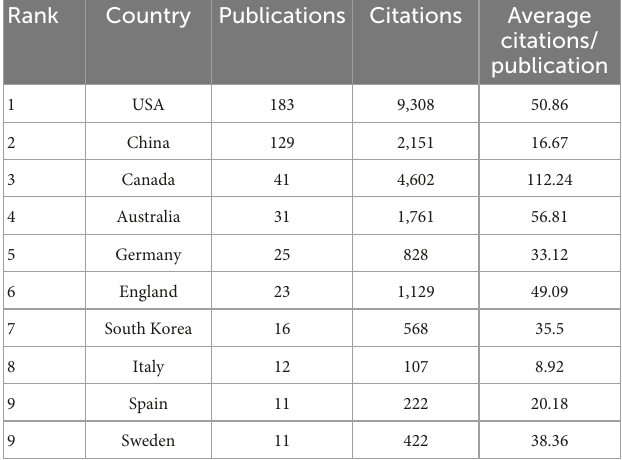
TABLE 3 Top 10 countries for publications of traditional Chinese exercises for musculoskeletal disorders.